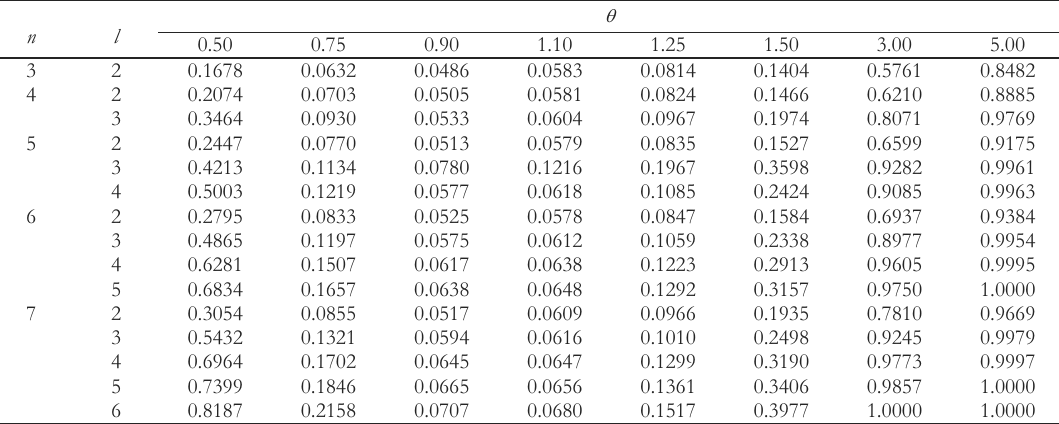
Power of Test 3 with SRSS data from the exponential distribution